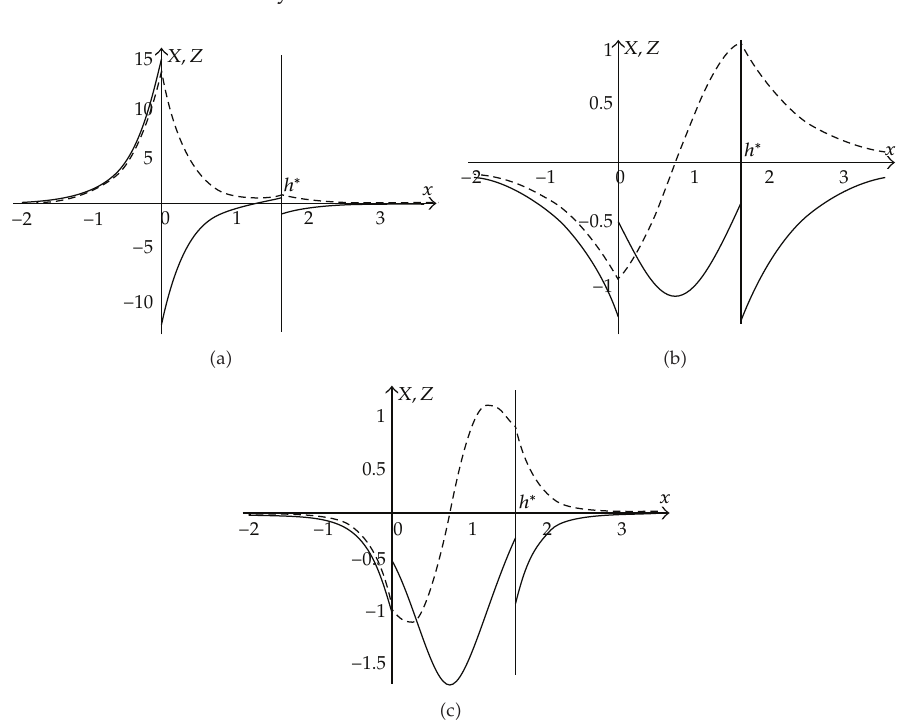
Figure 5: Eigenfunctions (cid:3) fields (cid:4) for the nonlinear problem are shown. Solid curves for X ; dashed curves for Z . The same parameters as in Figure 4 are used. For (cid:3) a (cid:4) , γ (cid:7) 2 . 620, and a (cid:7) 0 (cid:3) see (cid:3) 8.5 (cid:4)(cid:4) ; for (cid:3) b (cid:4) , γ (cid:7) 1 . 565; for (cid:3) c (cid:4) , γ (cid:7) 3 . 481, and h (cid:7) 1 . 71 is used for all three cases. The eigenvalues are marked in Figure 4.